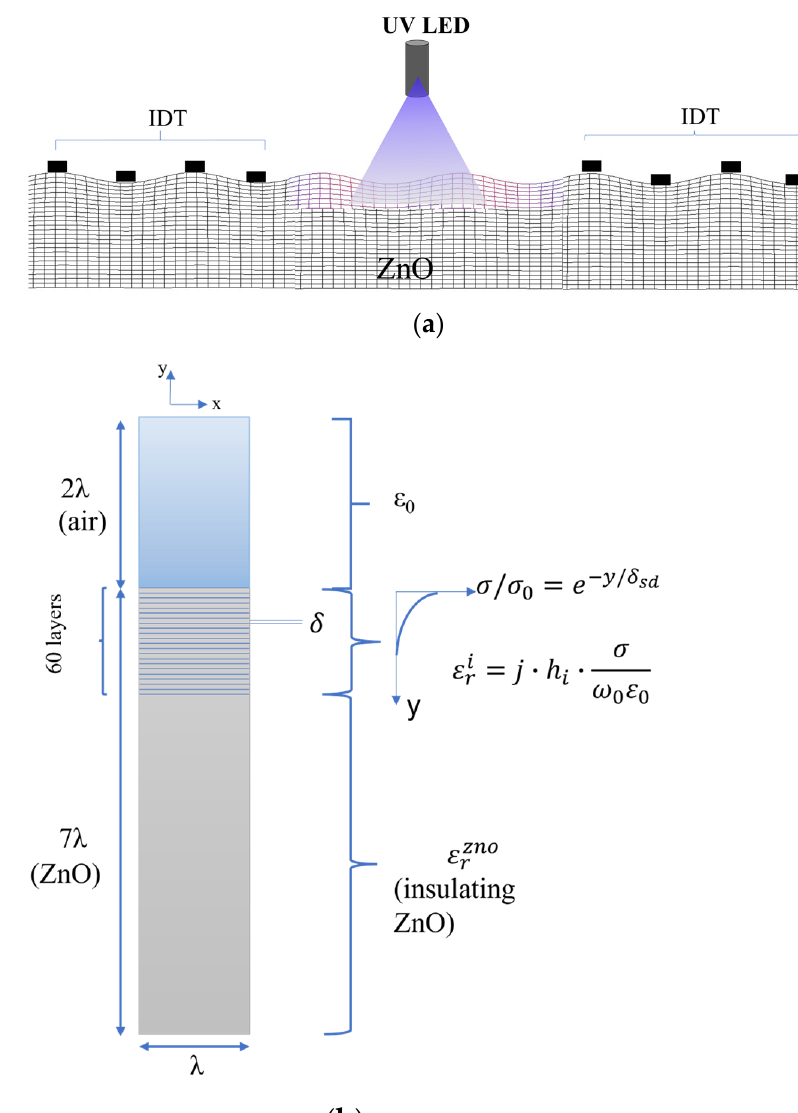
the structural properties of the photo-conducting material.